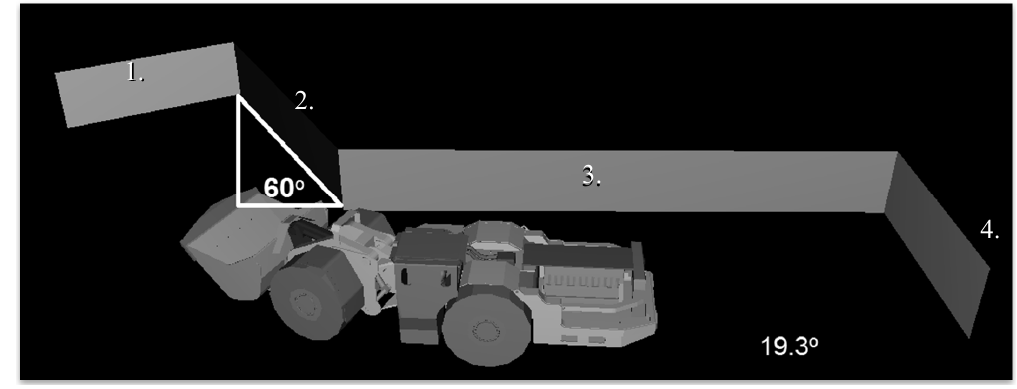
Figure 3. LHD articulated 19.3° as it turns in a 60° drift.